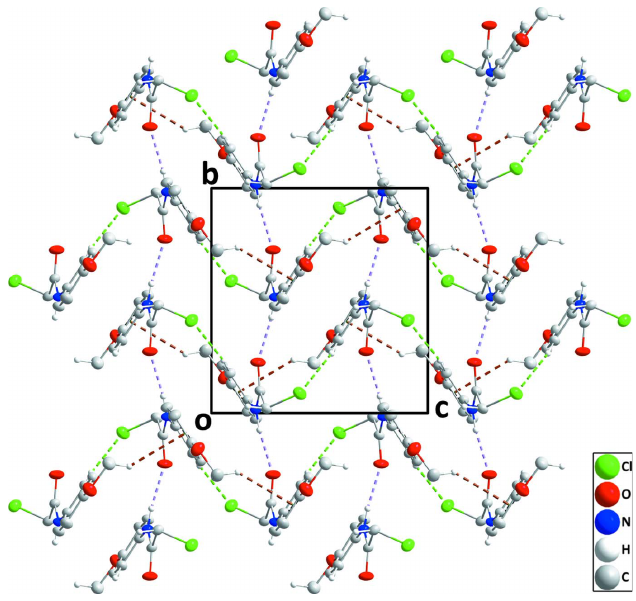
Figure 3 Packing viewed along the a -axis direction with N—H (cid:2)(cid:2)(cid:2) O, C—H (cid:2)(cid:2)(cid:2) O and C—H (cid:2)(cid:2)(cid:2) Cl hydrogen bonds depicted, respectively by violet, black and light green dashed lines. C—H (cid:2)(cid:2)(cid:2) (cid:2) (ring) interactions are depicted by brown dashed lines and non-interacting hydrogen atoms are omitted for clarity.